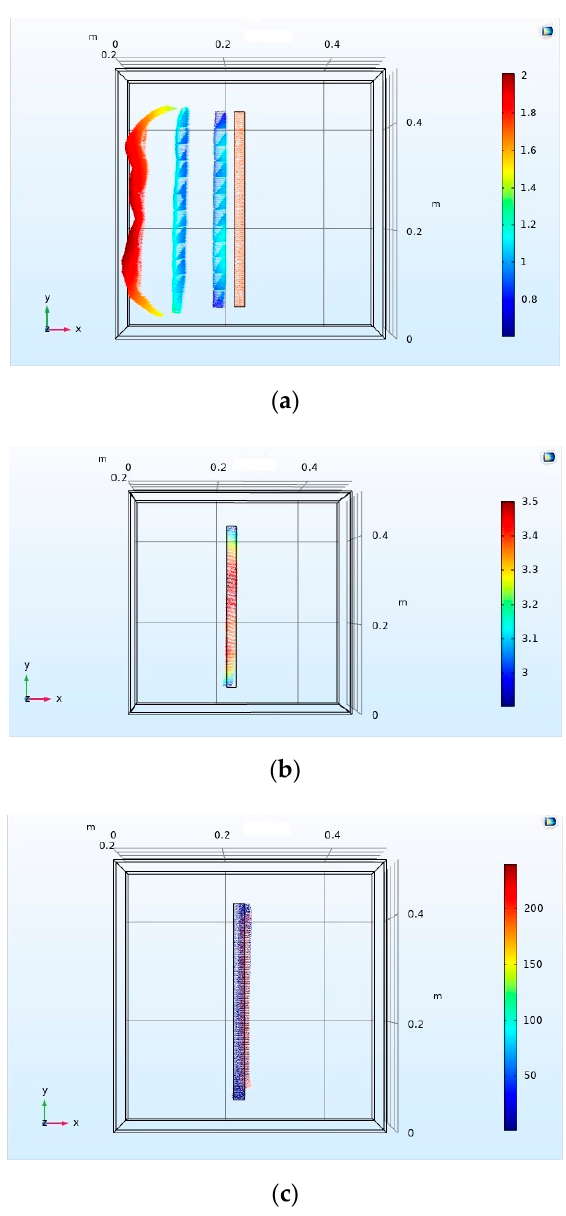
Figure 16. Simulation effect of separation of atmospheric particles: ( a ) PM 100 ; ( b ) PM 10 ; ( c ) PM 2.5 .